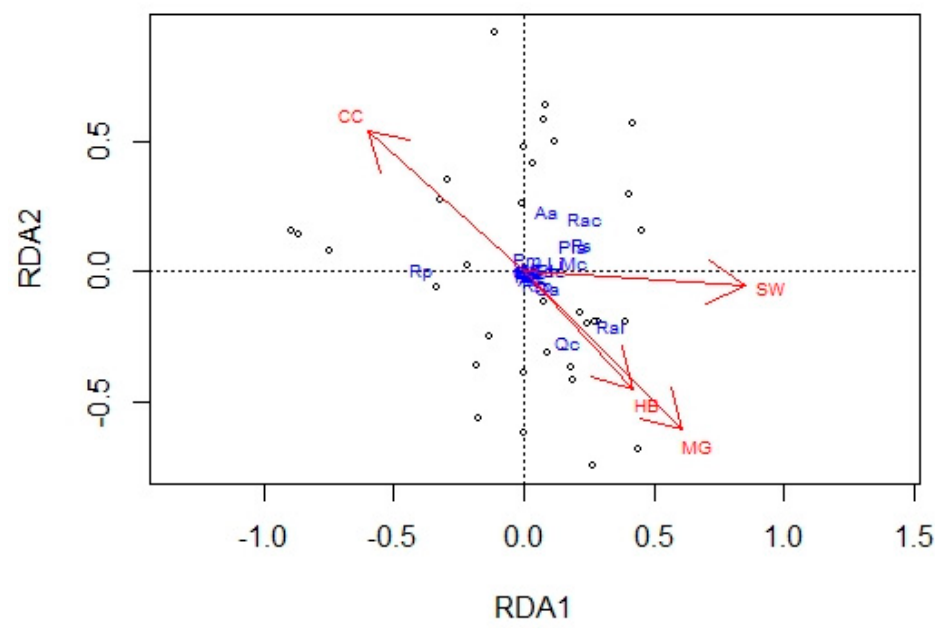
Figure 3. RDA tri-plot exploring the relationships between the frequency of each species, the overstory variables (CC—Canopy Cover, HB—Hart–Becking) and the understory indices (SW—Shannon, MG—Magini). White circles represent the plots. For species symbols (in blue), see Table 2.